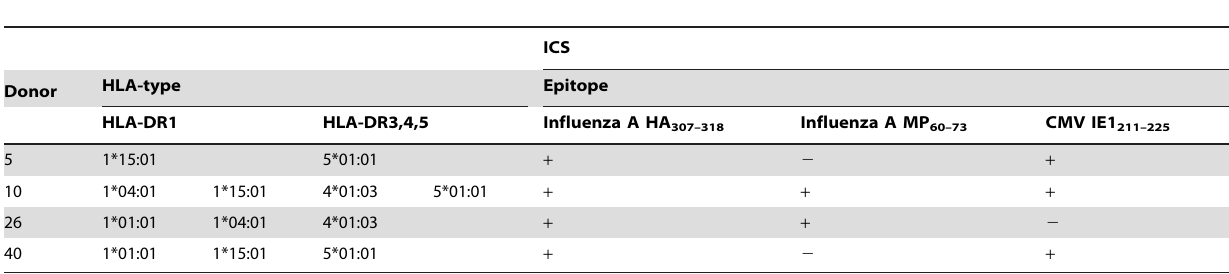
Table 2. Overview of donors, HLA class II DR alleles of individual donors, and cytokine (IFN- c and TNF- a ) responses measured